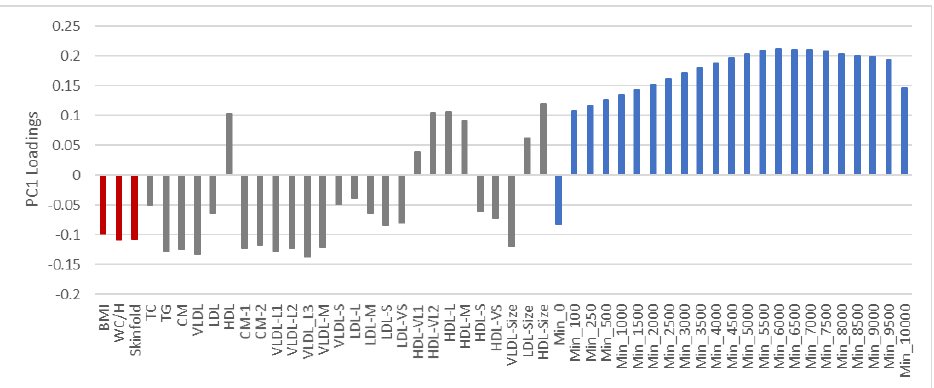
Figure 1. Loading plot displaying the partial correlations of lipoproteins, adiposity, and physical activity explaining 30.6% of the total remaining variance in the variables after adjusting for age and sex. The following color code is used to specify different kinds of variables: Red for adiposity, grey for lipoproteins, and blue for physical activity. For the physical activity variables, the names imply the lowest intensity levels in each intensity interval defined in Section 2.3. For instance, the name Min_0 implies the intensity interval 0–99 cpm.